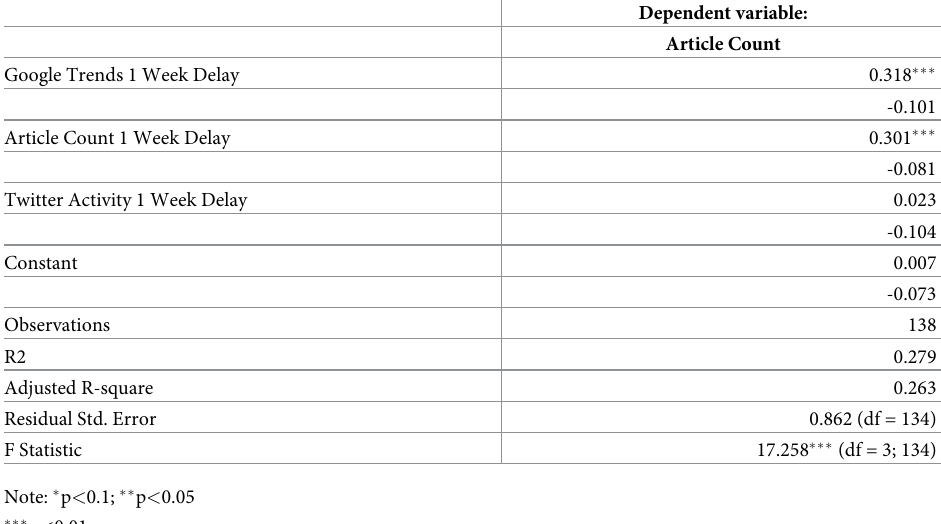
Table 4. Newspaper coverage effect on Google search behavior and Twitter